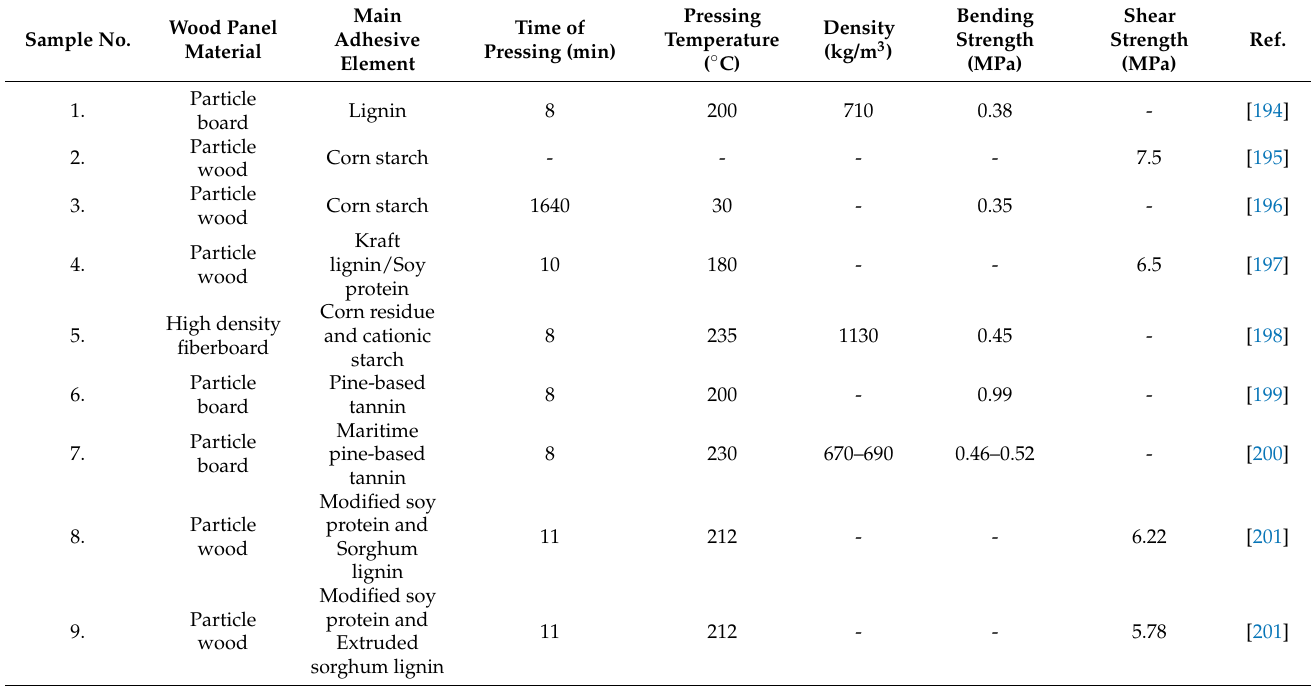
Table 2. Processing parameters of bioadhesives for WPC